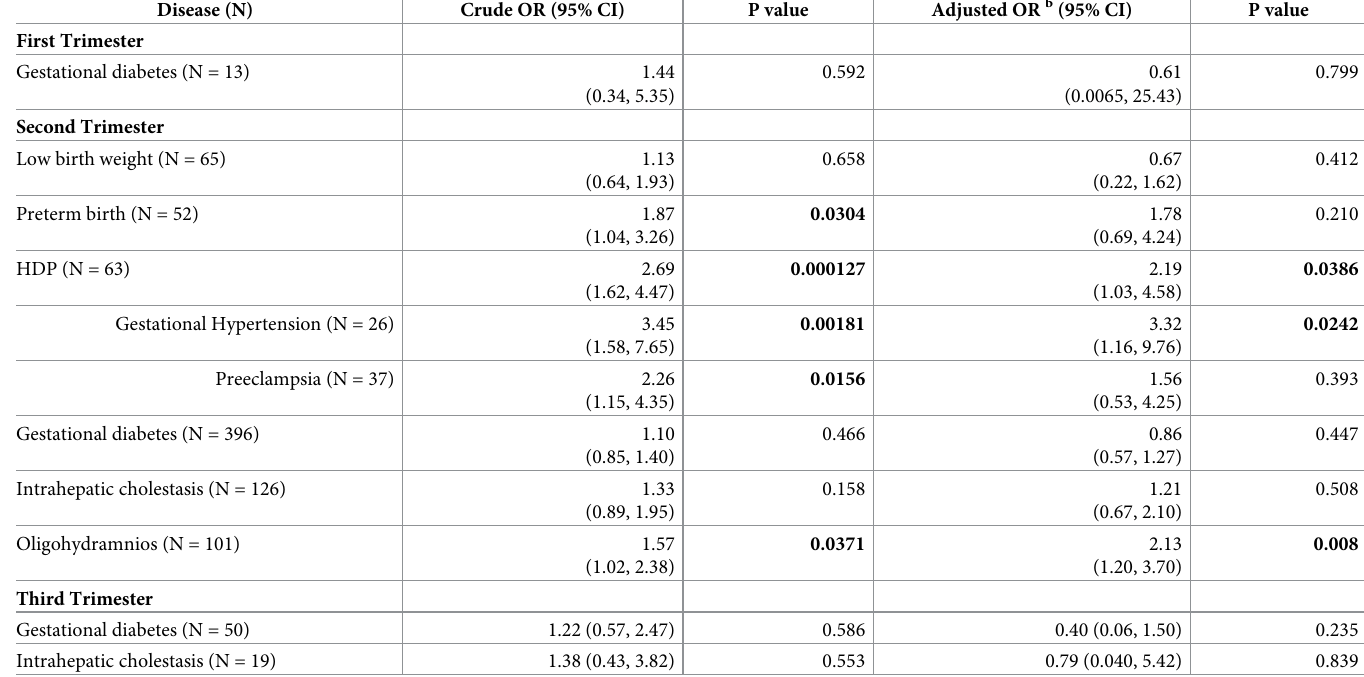
Table 4. Relationship between fetal fraction (Fetal fraction < 25th percentile vs. fetal fraction � 25th percentile a ) and pregnancy-related complications stratified by gestational age at NIPT. Disease (N) Crude OR (95% CI) P value Adjusted OR b (95% CI) P